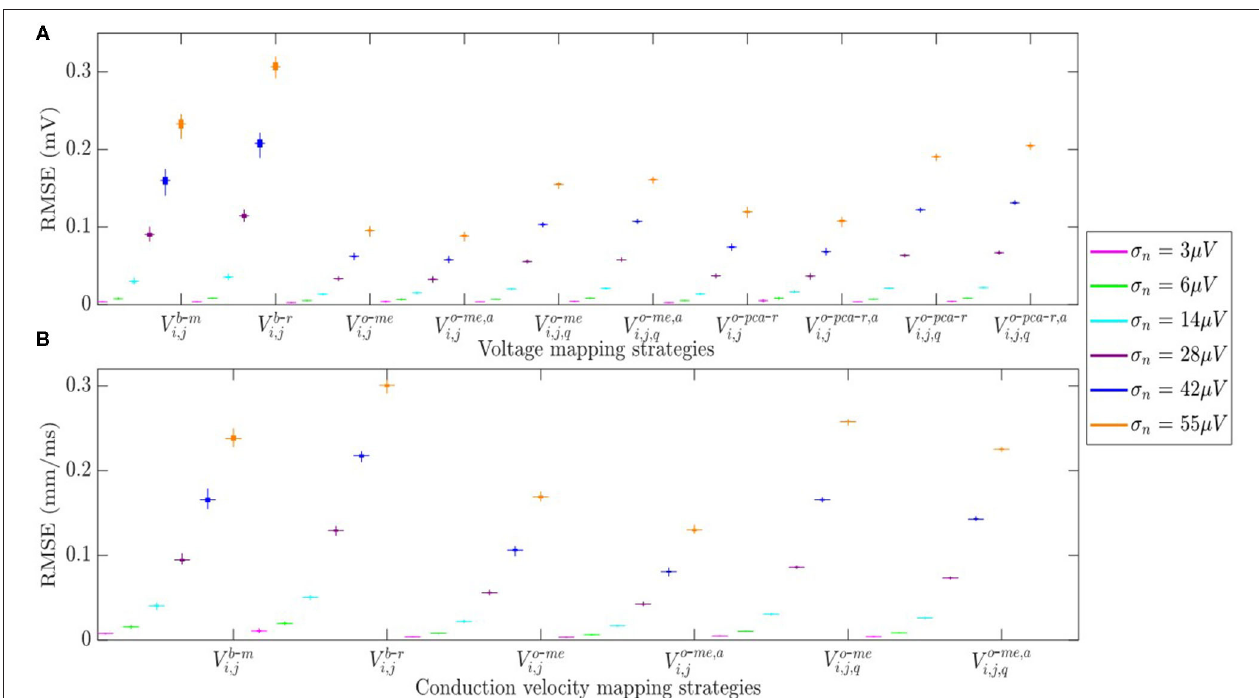
FIGURE 10 | (A) RMSE for voltage mapping strategies. (B) RMSE for velocity mapping strategies. For each noise level, the central mark and the bottom and top edges of each box indicate the median, the first and the third quartile, respectively.